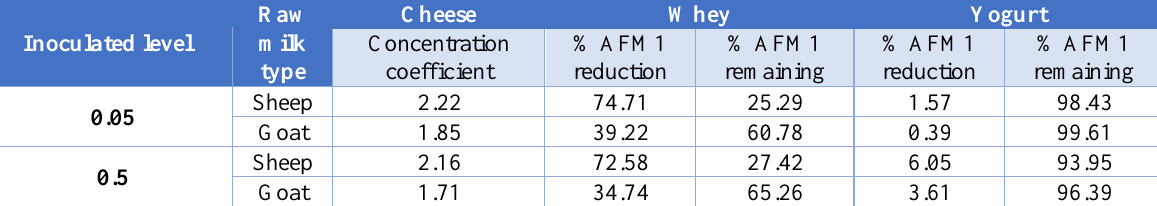
Table, 3: Concentration coefficient of AFM1 in soft white cheese and the percentages of AFM1 reduction and AFM1 remaining in both whey and yogurt manufactured from raw sheep's and goat's milk at both inoculated levels (0.05 and 0.5 μg/l). Inoculated level